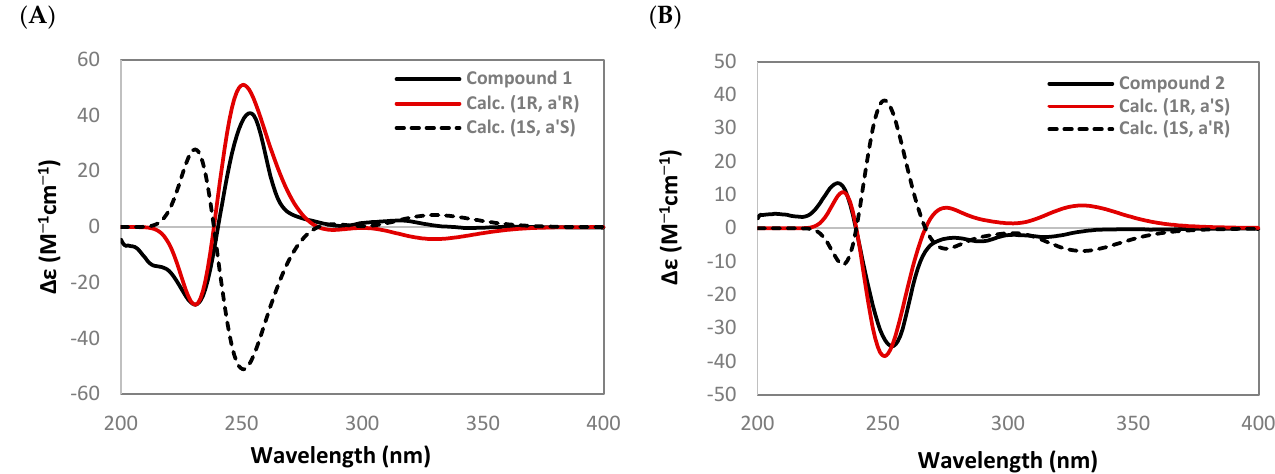
Figure 3. Experimental and calculated CD spectra of 1 ( A ) and 2 ( B ).